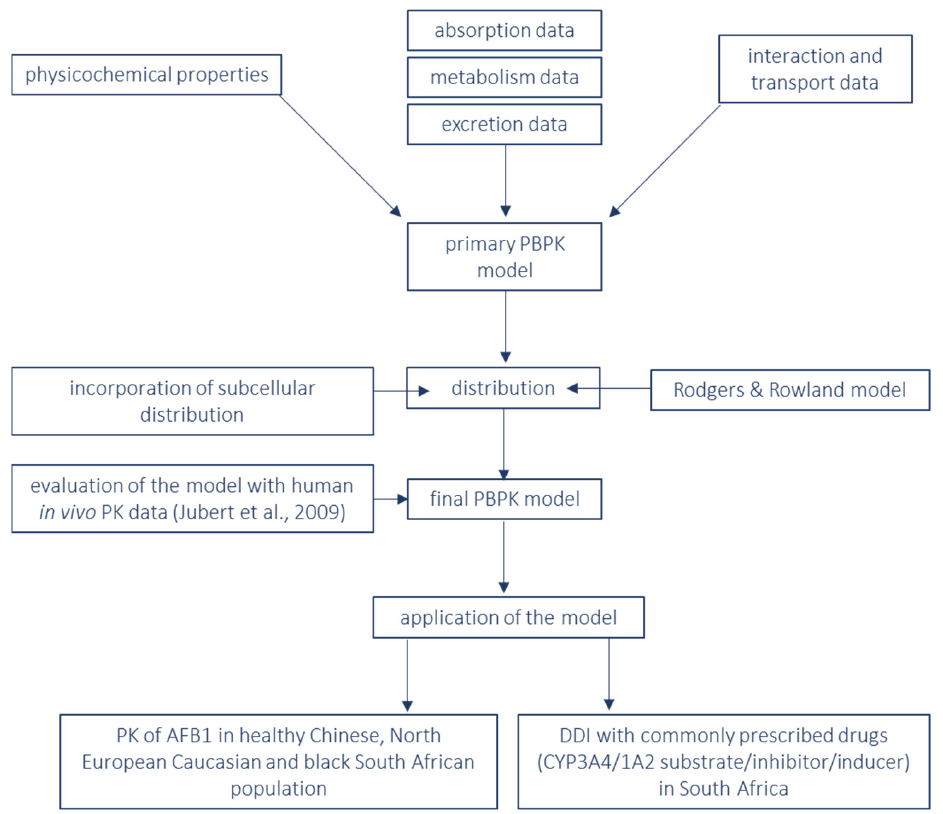
Figure 2. Flowchart of the bottom-up approach for building a PBPK model for substrate aflatoxin B1 and its applications [28]. PBPK = physiologically based pharmacokinetics; PK = pharmacokinetics; AFB1 = aflatoxin B1; DDI = drug–drug interaction; CYP = cytochrome P 450. Table 1. Physicochemical properties, blood-binding, absorption, distribution, elimination, interaction and transport information for AFB1.